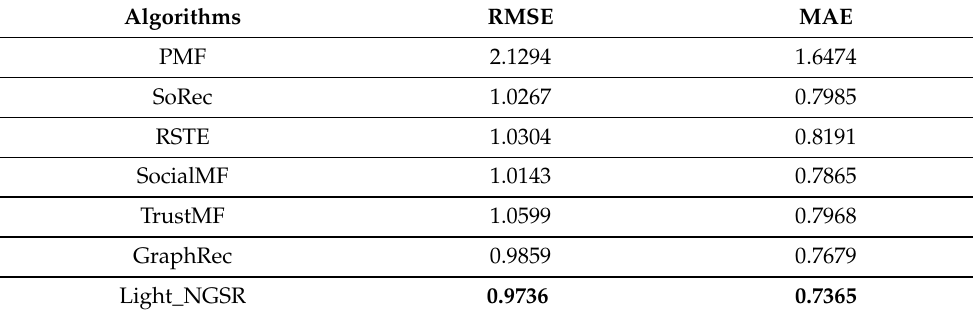
Table 3. Performance comparison on Ciao.